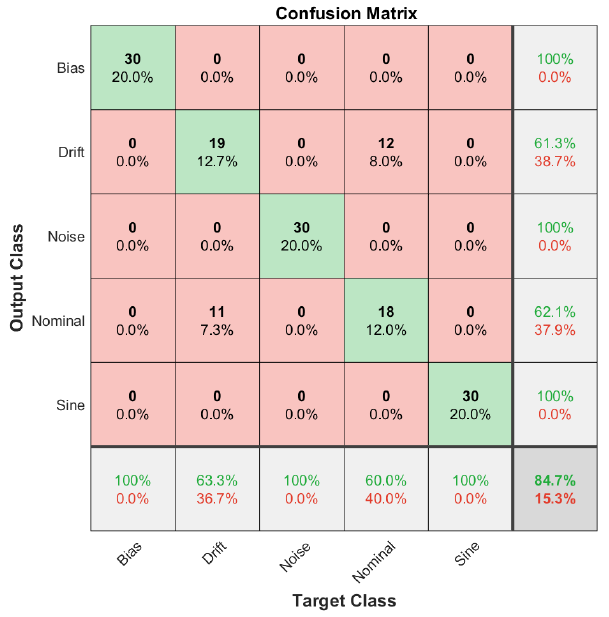
Figure 14. Confusion matrix for the test data set showing that a considerable amount of the misclassi- fied samples are between drift fault and nominal scenarios.